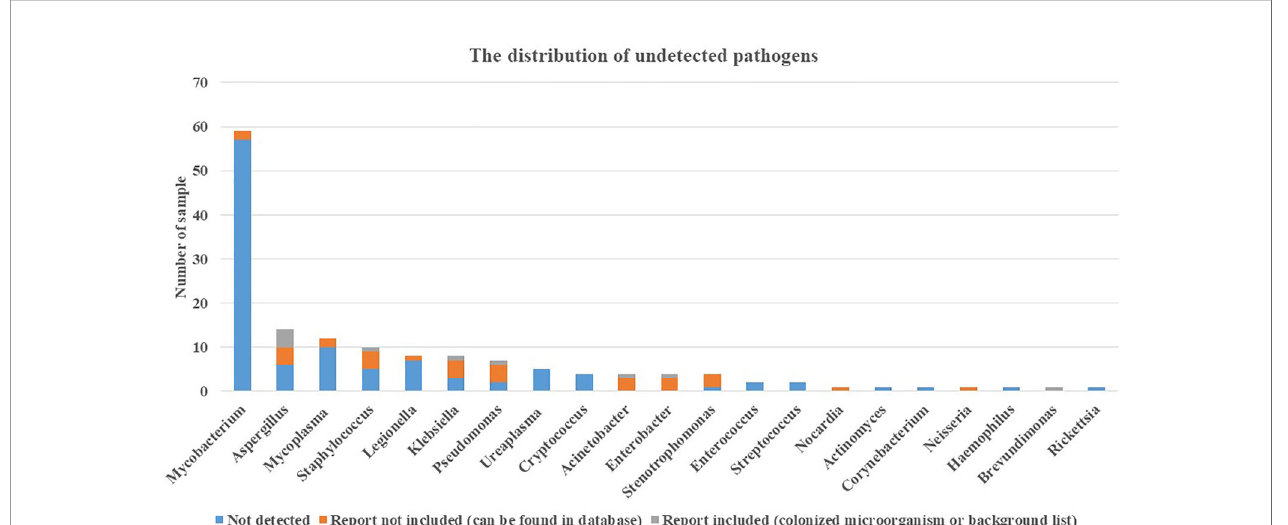
FIGURE 5 | Distribution of undetected pathogens. Pathogens detected positive in assays include culture, mNGS (other sample types), TSPOT, CrAg, immunoassay, G test, and GM test were further classi fi ed in no sequence detected in mNGS, report included, and report not included. mNGS, metagenomics next-generation sequencing; TSPOT, TSPOT.TB; CrAg, cryptococcal antigen; G test, 1-3- b -D-glucan test; GM test, galactomannan test.